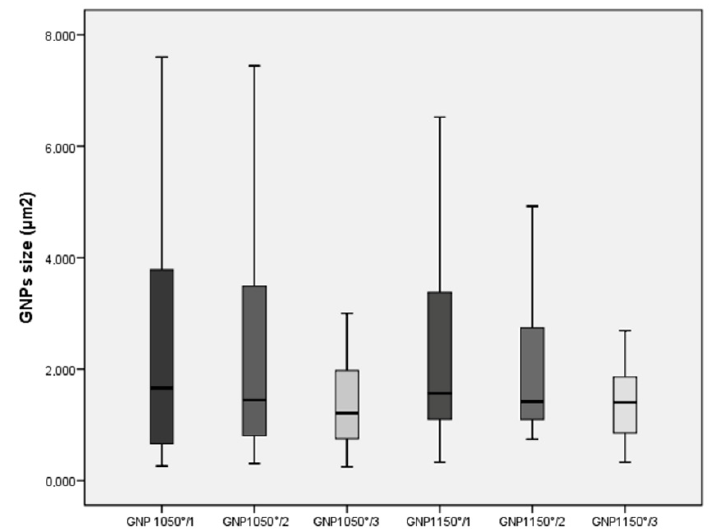
Figure 2. Box plots showing the median, quartile, and minimum and maximum values of the size (µm 2 ) of the GNPs in the six different groups. Boxes contain 50% of all values; the horizontal lines inside the boxes indicate the medians and the vertical lines extend to 1.5 of the interquartile range. Table 2. Differences in sizes of the six GNP groups.